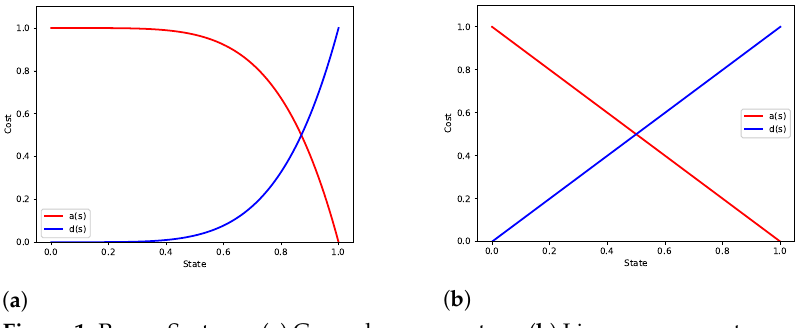
Figure 1. Power Systems. ( a ) General power system. ( b ) Linear power